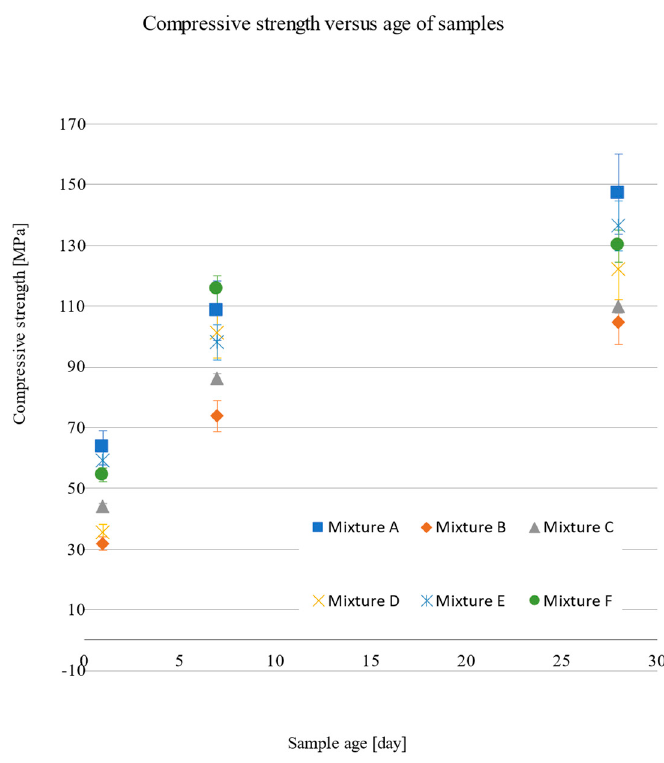
Figure 7. Compressive strength as a function of the age of the sample.